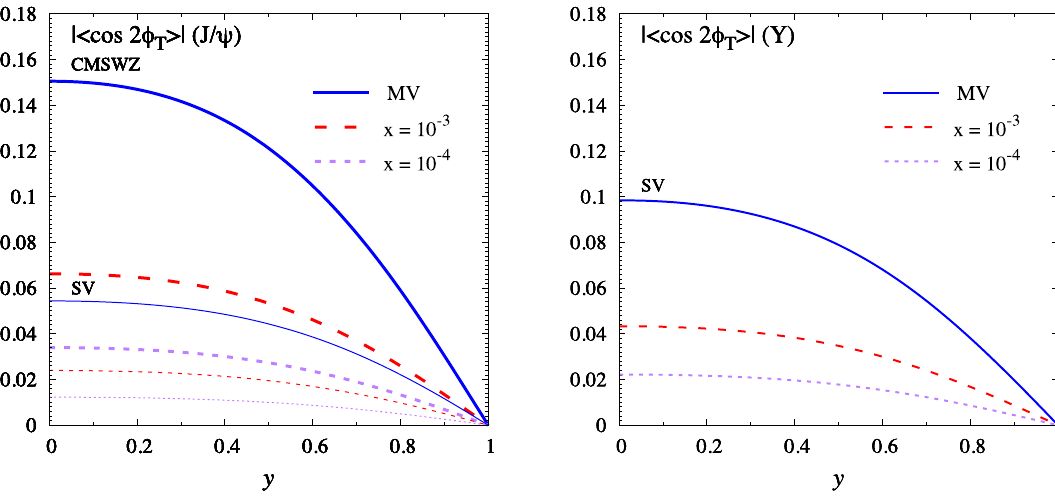
Fig. 9 (cid:2) cos2 φ T (cid:3) asymmetries as a function of y for the processes e p → e (cid:5) J /ψ X (left panel) and e p → e (cid:5) ϒ X (right panel), calculated at Q = 1 GeV and q T = 1 . 5 GeV. The labels SV and CMSWZ denote the adopted LDME sets, given in Tables 1 and